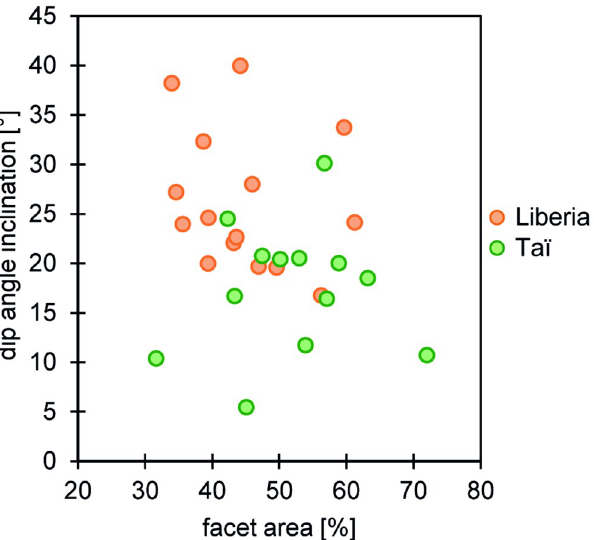
Fig 2. Facet area and dip angles of phase II wear facets of the upper second molars compared between both chimpanzee populations.